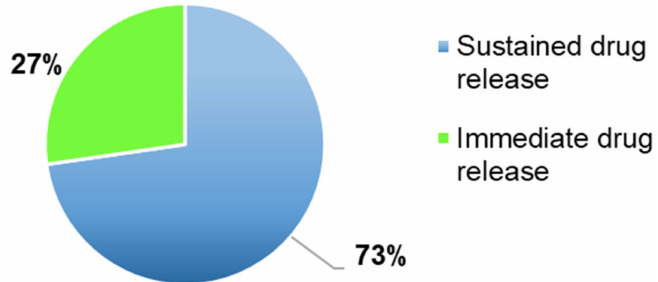
Figure 8. Representation of the two different drug release profiles, (1) sustained drug release (blue); (2) immediate drug release (green), which are shown by the 3DP formulations in the included FDM